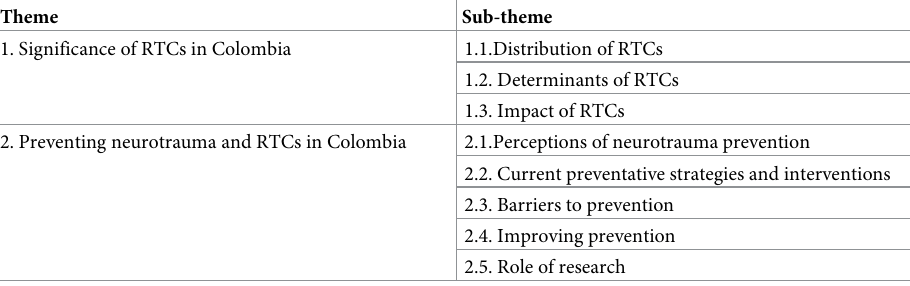
Table 2. Themes and sub-themes from key informant